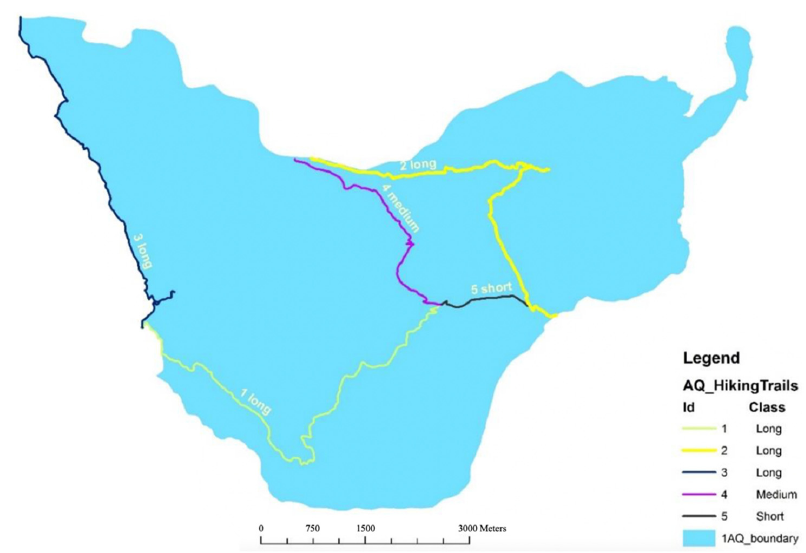
Figure 3. Tourism hiking trails in Abu Qubies protected